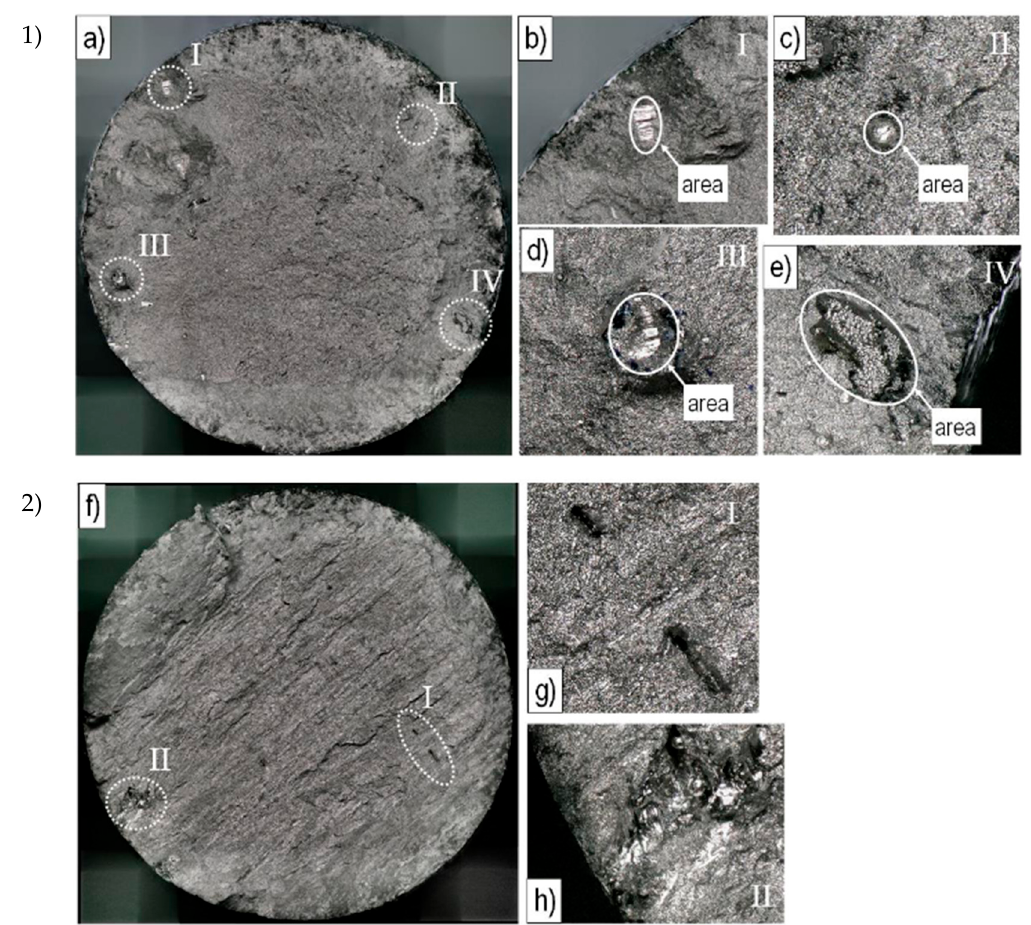
Figure 5. Different representative defect types in failed tensile samples for ( 1 ) the vertical and ( 2 ) diagonal build direction. Overview of the fracture surfaces in ( a ) and ( f ) with a magnification of defects in ( b )–( e ) and ( g )–( h ), respectively.